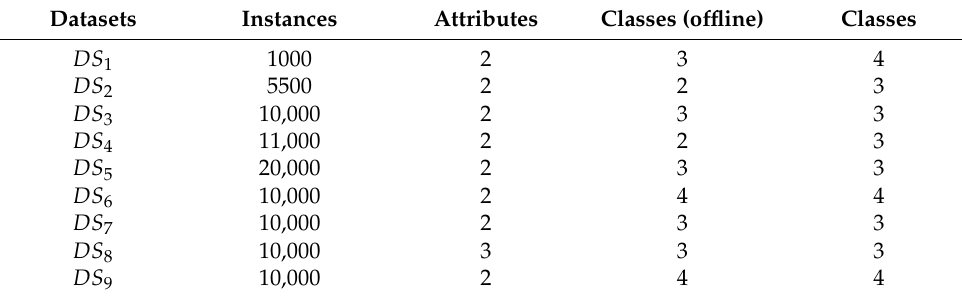
Table 2. Benchmark datasets used in experiments.